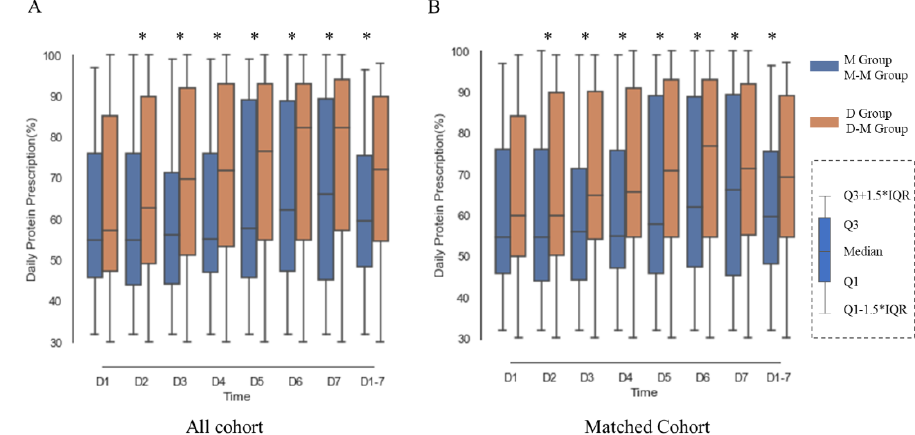
Figure 2. Percentage of daily protein prescription in protein goal (DPP%) through the observational period in ( A ) unmatched cohort and ( B ) 1:2 propensity score matching cohort based on Model 1. ( A ) In the unmatched cohort, the mean DPP% was significantly higher (marked with an asterisk) in the tube-feeding domperidone group compared with IV metoclopramide group on day 2 (67.72 vs. 59.71, p = 0.024), day 3 (70.93 vs. 60.15, p = 0.002), day 4 (71.74 vs. 61.65, p = 0.005), day 5 (73.41 vs. 64.91, p = 0.026), day 6 (74.75 vs. 65.61, p = 0.009), and day 7 (75.61 vs. 65.20, p = 0.006), as well as average DPP% (71.11 vs. 62.43, p = 0.007). ( B ) In matched cohort, the mean DPP% was significantly higher (marked with an asterisk) in the tube-feeding domperidone group compared with IV metoclopramide group on day 2 (68.70 vs. 59.71, p = 0.019), day 3 (71.06 vs. 60.15, p = 0.004), day 4 (71.96 vs. 61.65, p = 0.005), day 5 (74.53 vs. 64.91, p = 0.009), day 6 (76.10 vs. 65.61, p = 0.008), and day 7 (76.49 vs. 65.20, p = 0.002), as well as average DPP% (71.77 vs. 62.43, p = 0.006). IQR: interquartile range. *: p < 0.05.